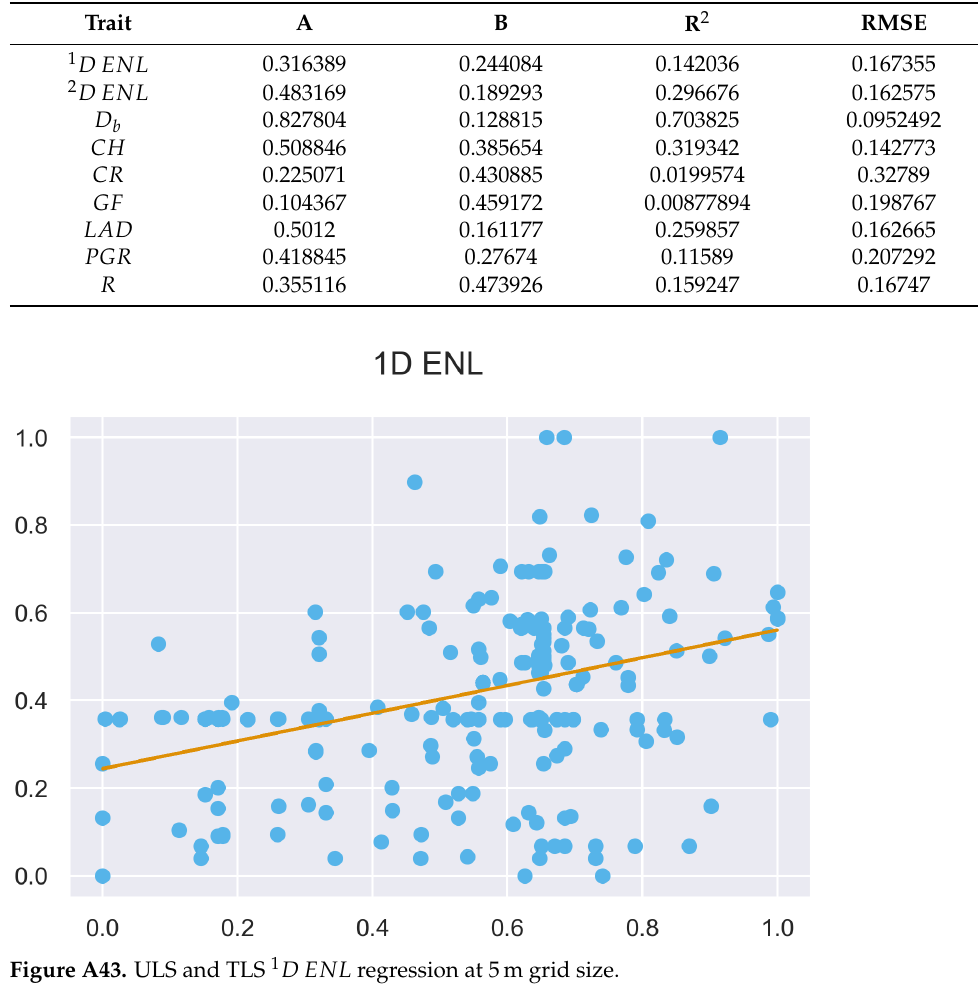
Figure A43. ULS and TLS 1 D ENL regression at 5m grid size.